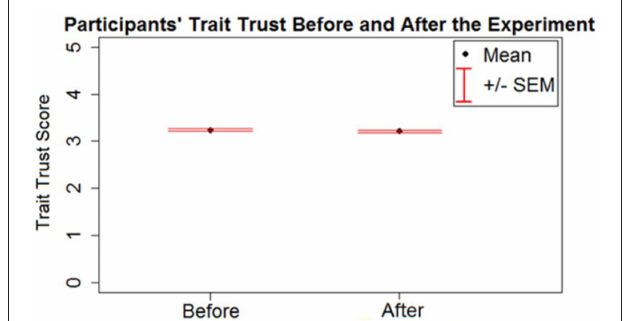
FIGURE 3 | Trait trust measured before and after the experiment; the error bars represent standard error of the mean.